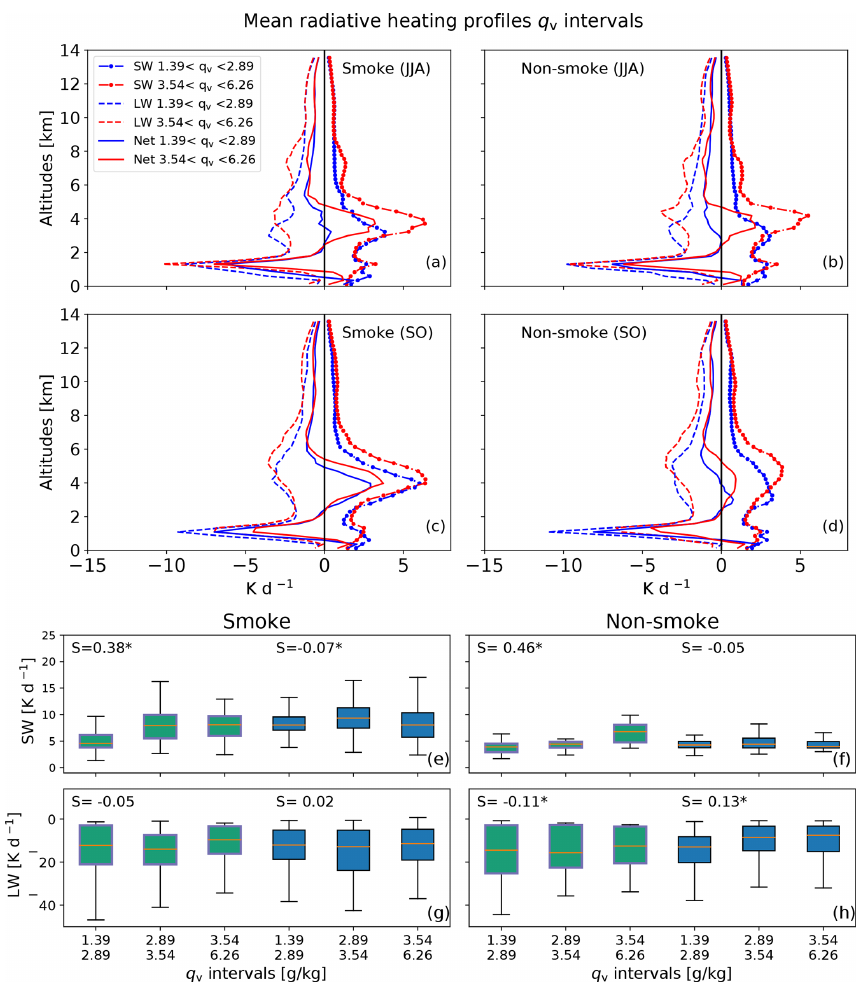
Figure A4. (a–d) Mean shortwave (SW), longwave (LW), and net (Net) radiative heating profiles for smoke and non-smoke cases with high and low RH June–July–August (JJA) and September–October (SO) of the period 2007–2010. (e–h) Box plots of SW heating in the aerosol layer (e, f) and LW cooling at cloud top (g, h) for three RH intervals. Panels (e, g) and (f, h) correspond to the smoke and non-smoke cases, respectively. Green boxes correspond to JJA and blue boxes to SO. For each case and period the Spearman correlation coefficient ( S ) between the full range of q v values and the SW (or LW) fluxes appears on top. Significant correlations (with p value < 0 . 05) are marked with a star ( ∗ ). q v values are derived from the CloudSat ECMWF-AUX